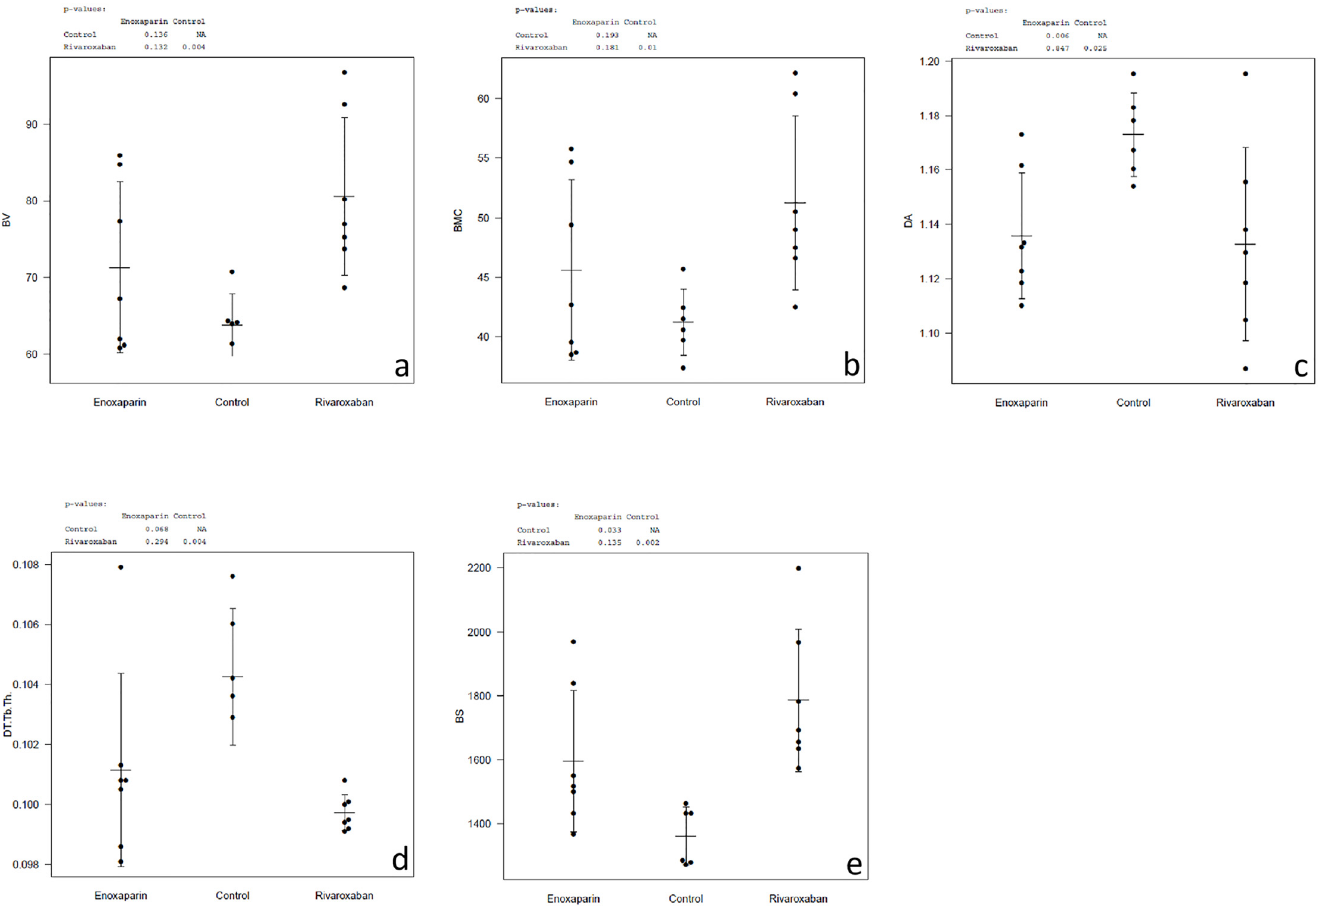
Fig 6. Summary Micro-CT Scan. Micro-CT based assessment of histomorphometry, black points indicate exact data, grey arbour mean data ± standard deviation. (a) Bone Volume BV (mm³) = mineralized callus volume: Significant difference of Rivaroxaban compared to control group (p = 0,004). (b) Bone Mineral Content = BMC defined as callus BV multiplied by TMD (mg hydroxyapatite/ ccm): Significant difference of Rivaroxaban compared to control group (p < 0,05). (c) Degree of Anisotropy = DA: Significant difference of both substances compared to control group (p < 0,05). (d) Trabecular Thickness = Tb-Th (mm): Significant difference of Rivaroxaban compared to control group (p < 0,05). (e) Bone Surface = BS (mm²): Significant difference of both substances compared to control group (p < 0, 05).